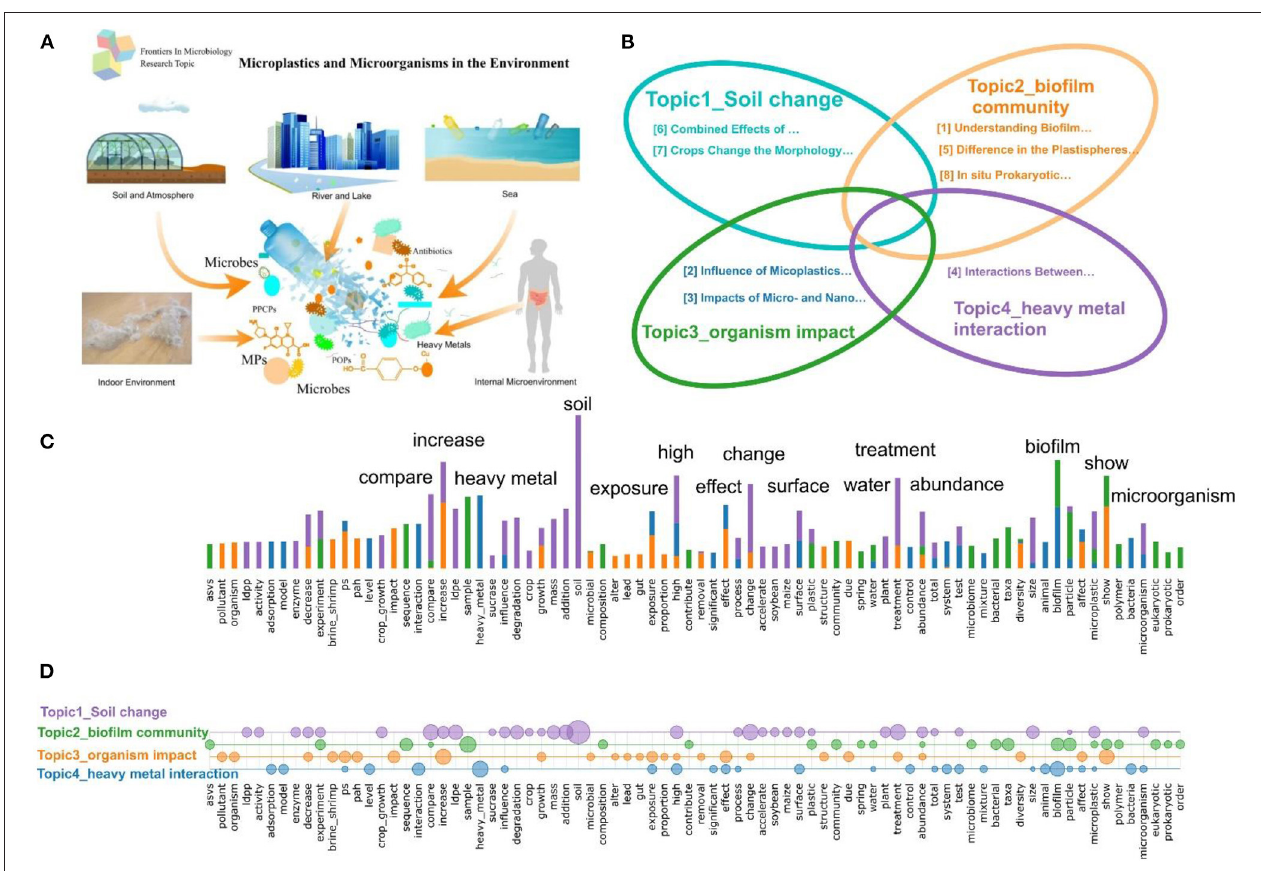
FIGURE 1 | (A) Schematic of the relationship between microplastics and microorganisms in the environment; (B) The four topics of this VSI; (C) Terms with high frequency in this VSI; (D) The distribution of some high-frequency terms among the four topics. The circle area represents the term frequency, and different colors represent different